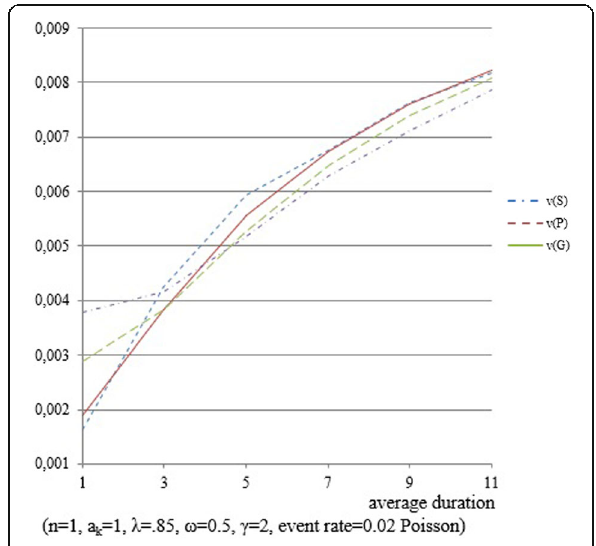
Fig. 6 Upper bounds of privacy risk v(A P ) for various average durations of privacy incidents